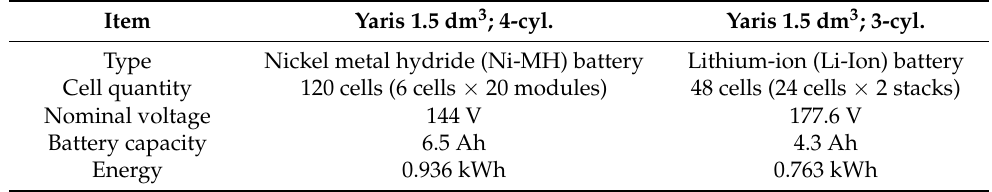
Table 4. Battery specifications in the analyzed hybrid powertrains